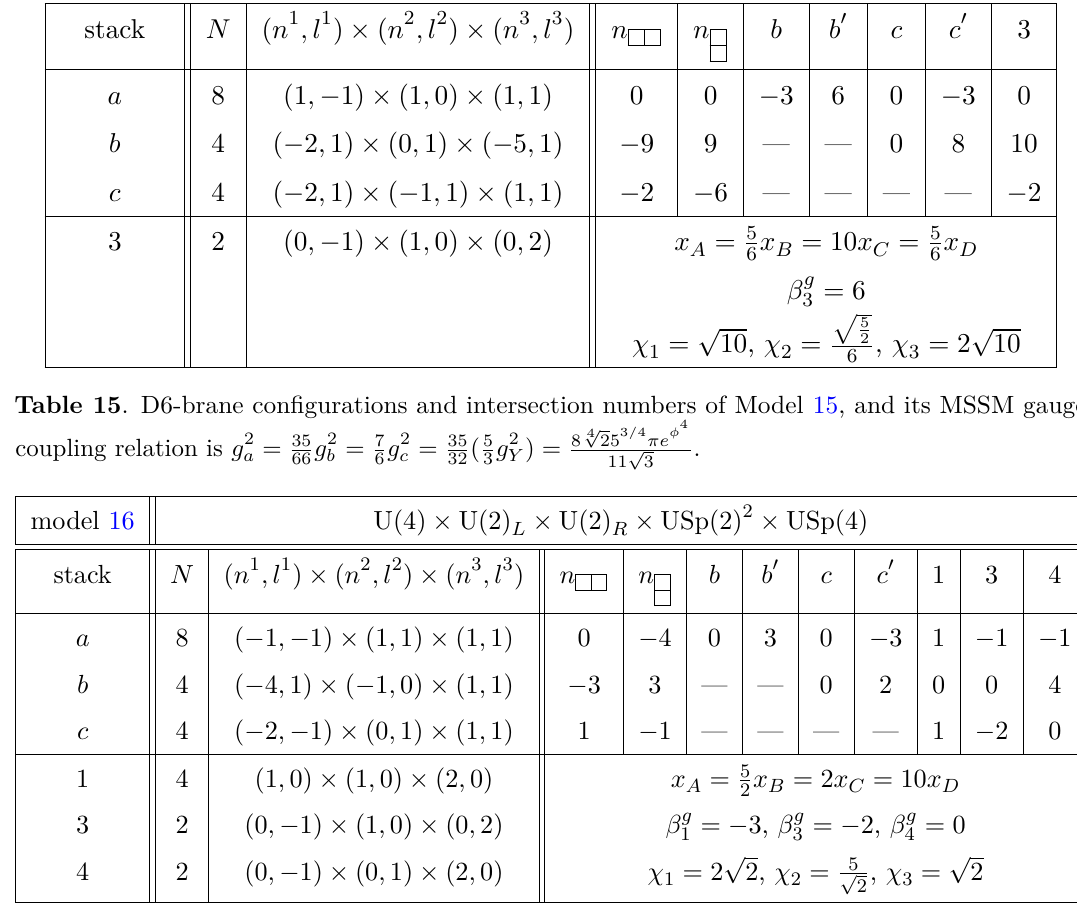
Table 16 . D6-brane configurations and intersection numbers of Model 16, and its MSSM gauge